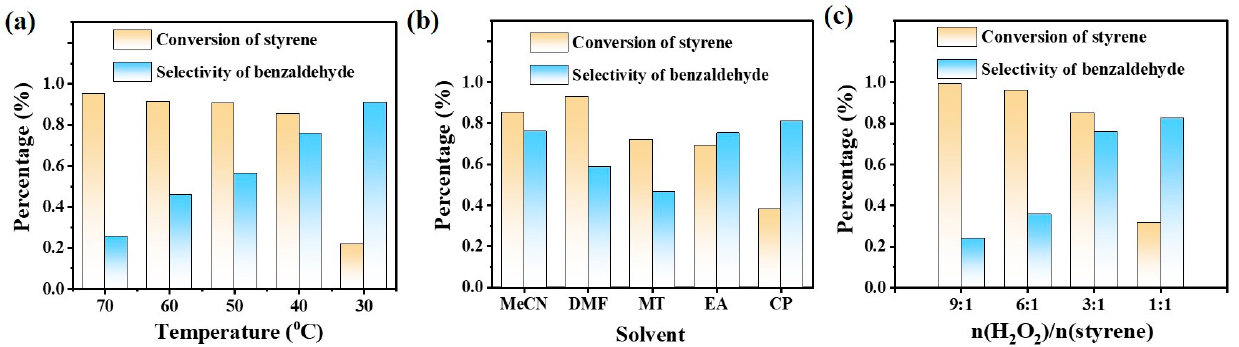
Figure 5. The effects of ( a ) temperature, ( b ) solvent, and ( c ) the amount of oxidant on the catalytic performance over Cu 2 O@Cu-BDC-NH 2 -8h for the selective oxidation of styrene.